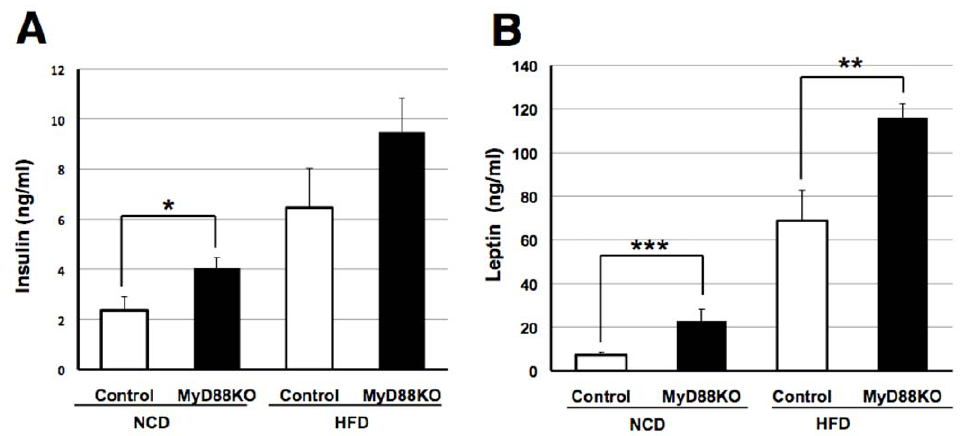
Figure 3. Increased circulating levels of insulin and leptin in MyD88-deficient mice. ( A ) Plasma insulin was measured in each genotype fed the NCD (n=9–10) or HFD (n=10–15) at the age of 16 weeks. * p , 0.05 ( B ) Plasma leptin was measured in each genotype fed the NCD (n=9–16) or HFD (n=11–12) at the age of 16 weeks. ** p , 0.01, *** p , 0.001.